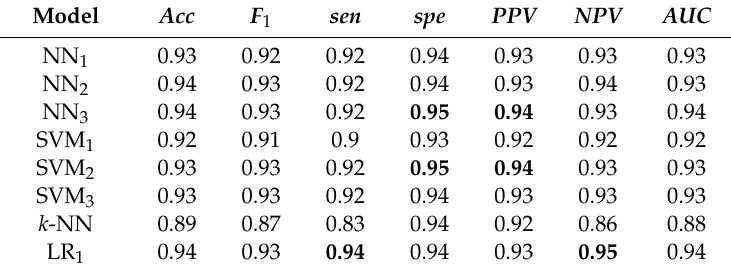
Table 7. Performance comparison of black box (BB)–WB